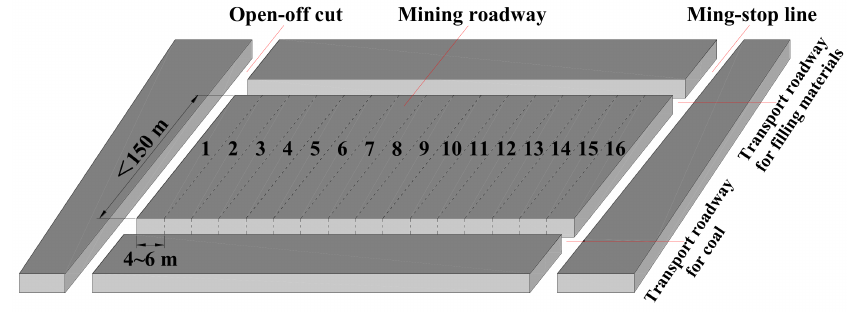
Figure 4. The arrangement of the mining panel in the CECB method in longwall mining.